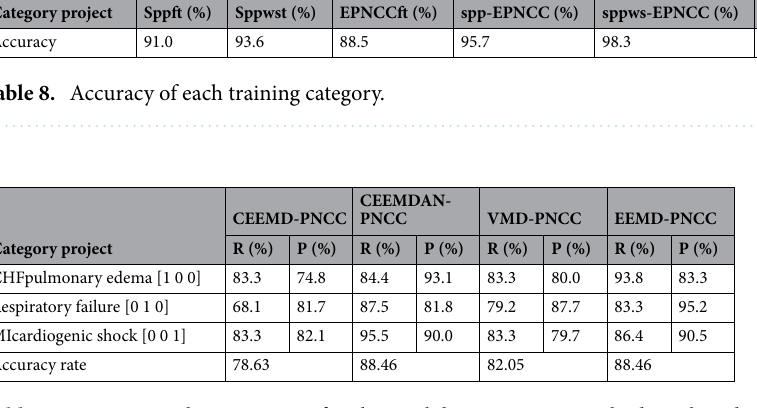
Table 9. Experimental comparison of each signal decomposition method combined with PNCC (R: recall rate, P: precision).